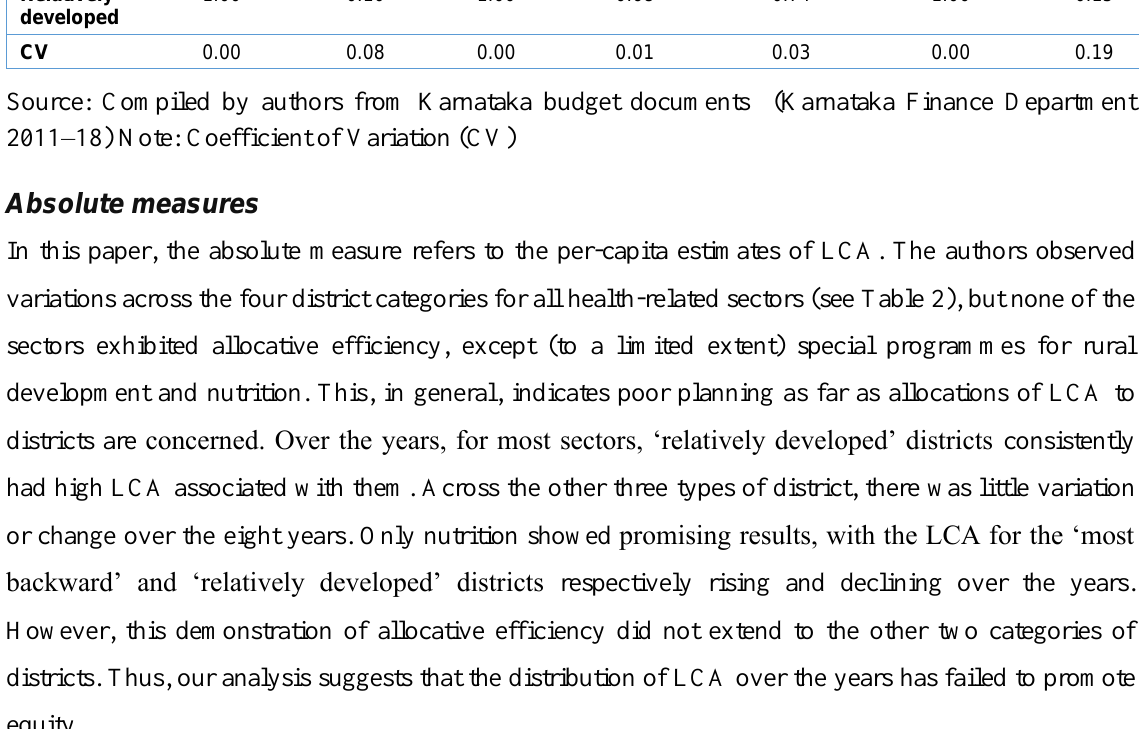
Table 2: LCA and its variability across different district categories (absolute measures - INR per capita) Category (average values)